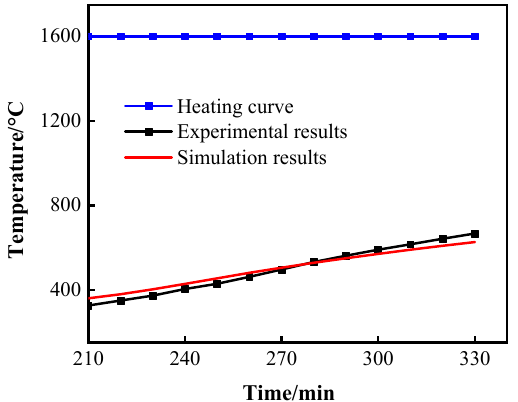
Figure 3. Temperature variation curve of coil ambient temperature.